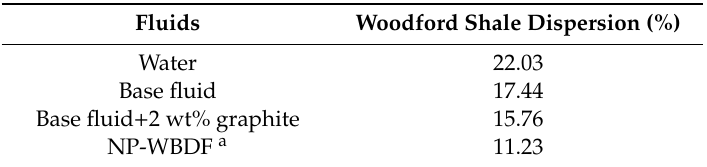
Table 4. Dispersion (%) of Woodford shale in di ff erent fluids [133].